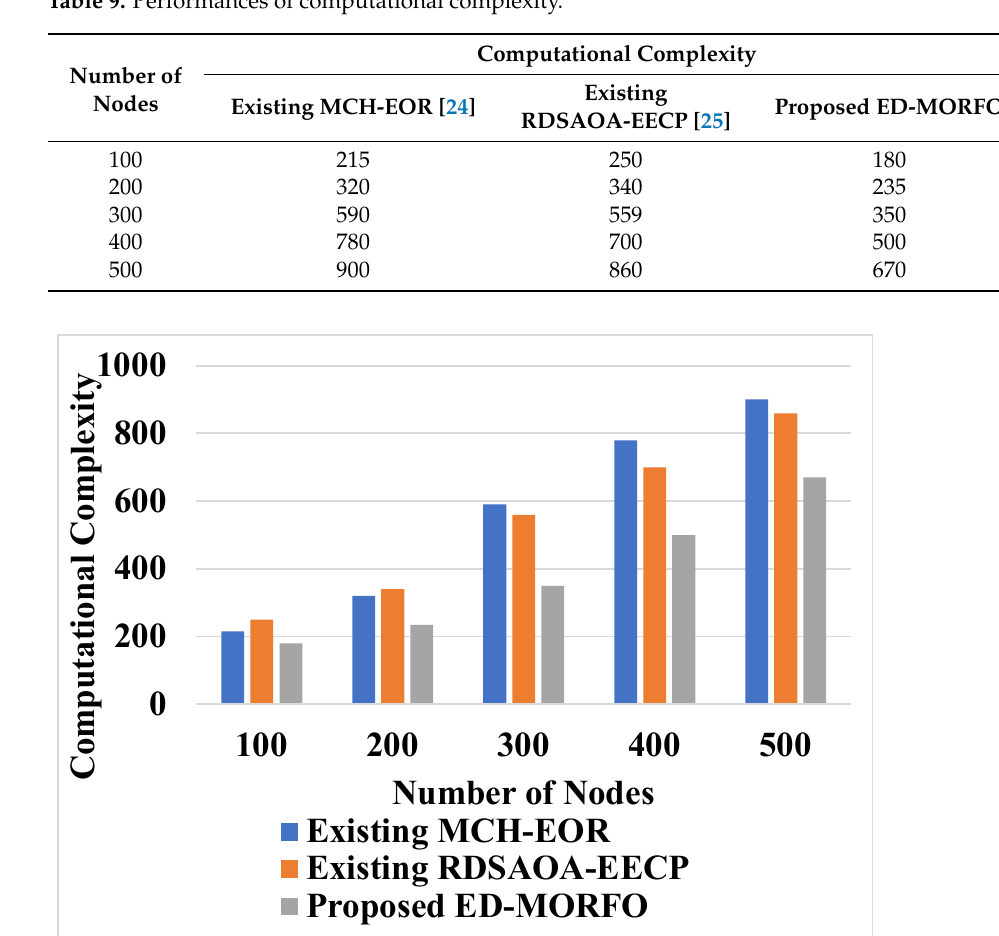
Table 9. Performances of computational complexity.